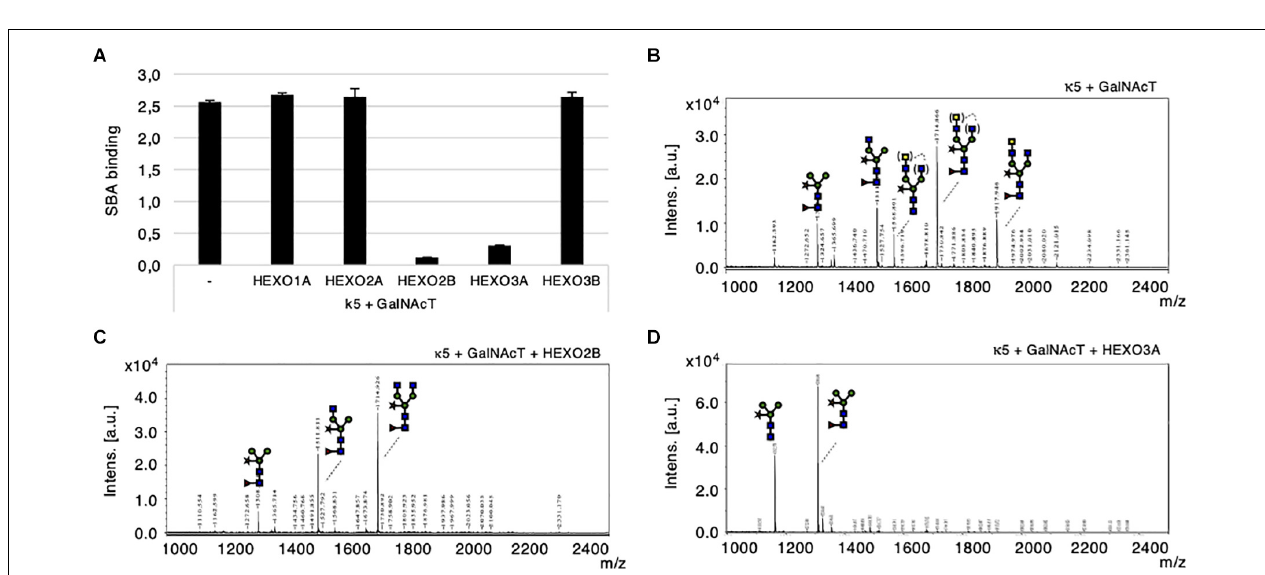
FIGURE 5 | Cleavage of engineered LDN motifs by N. benthamiana HEXOs. Kappa-5 was co-expressed with p19, CeGalNAcT and different HEXO genes in wild-type plants. After isolation of the apoplast fluid (at 6 dpi) the presence of the LDN motif on kappa-5 N-glycans was analyzed. (A) Soybean agglutinin (SBA) binding assay for detection of terminal GalNAc. Lectin binding is measured as absorbance at 450 nm. (B–D) Kappa-5 was purified from the apoplast fluid and the N-glycan composition was analyzed by MALDI-TOF-MS. MS profiles are given for N-glycans of kappa-5 upon co-expression of GalNAcT only (B) , or combined with co-expression of HEXO2B (C) , or HEXO3A (D) . When a MS peak represents multiple N-glycan structures of identical mass, the possible positions of these sugar residues on the N-glycan are indicated between brackets. m/z refers to mass-to-charge ratio.